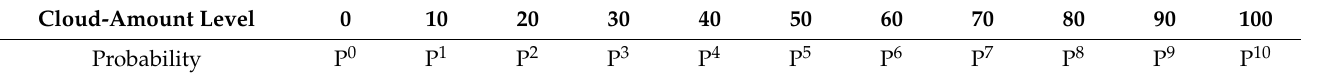
Table 1. Probability distribution table of cloud-amount